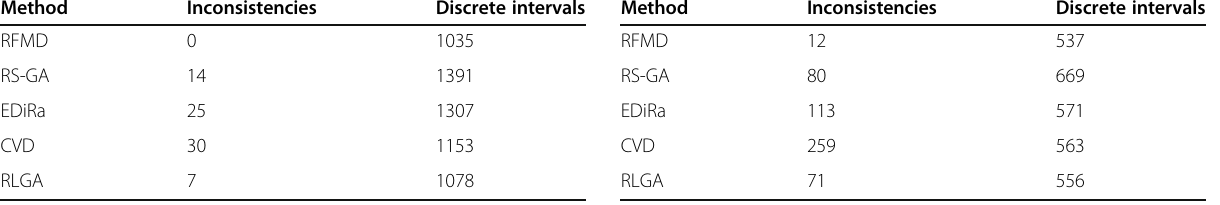
Table 4 Number of data errors in GF-2 image Method